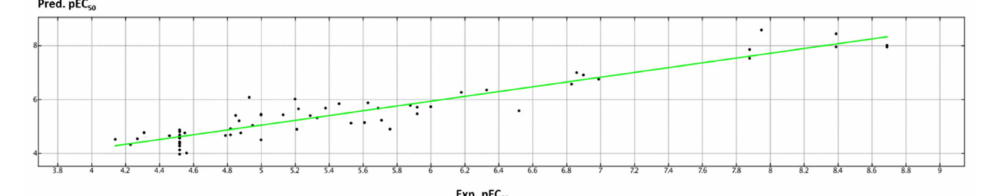
Figure 14. Distribution of the predicted (Pred.pEC 50 ) and experimental (Exp.pEC 50 ) potency values of the dataset compounds (shown as black dots).